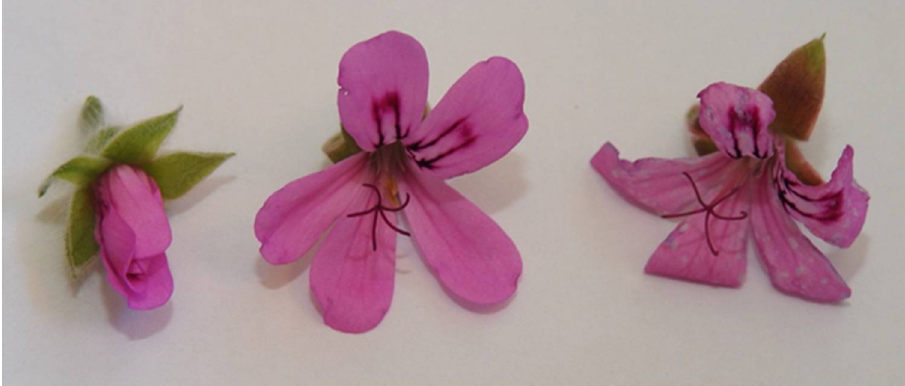
Figure 1. Flowers of P. ‘Endsleigh’ at three flowering stages: mature bud, full bloom and senescing.